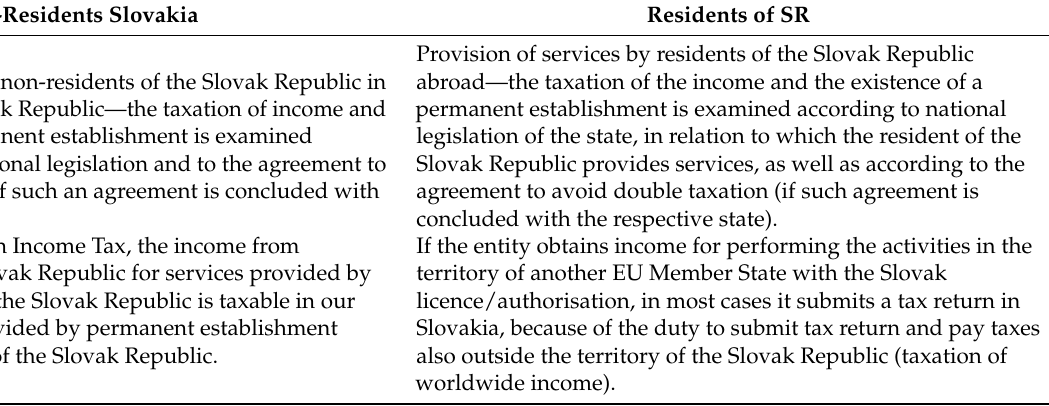
Table 2. Taxation of income from cross-border business